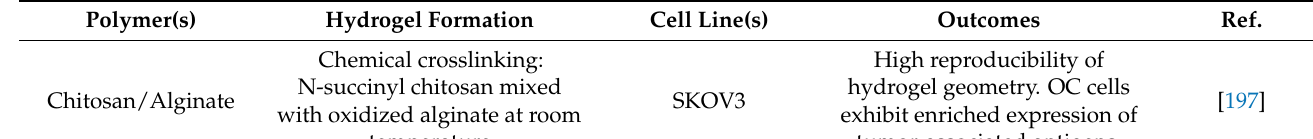
Table 4. Three-dimensional culture systems of OC cells combined with polymeric